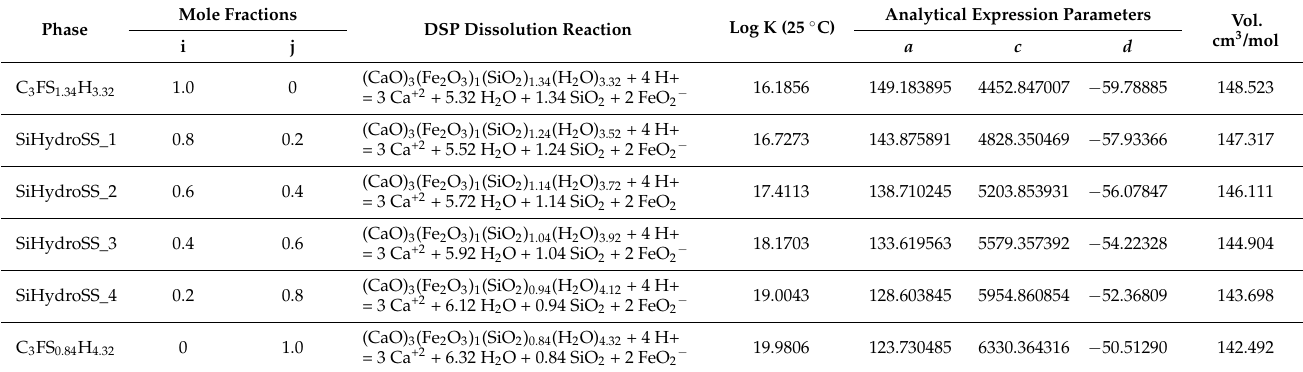
Table 8. End-members and DSP for the Si-hydrogarnet